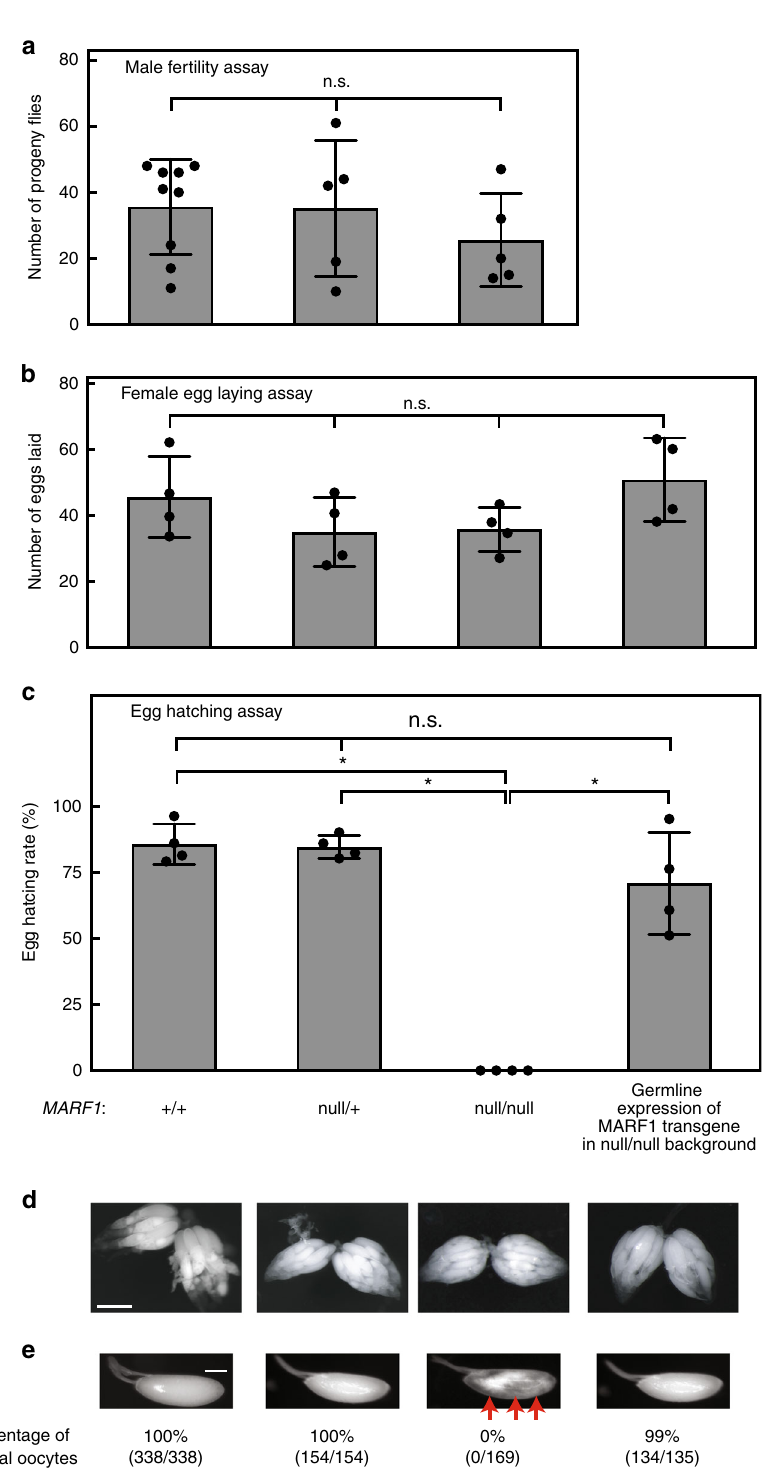
Fig. 2 MARF1 null female fl ies are sterile and have abnormal stage 14 oocytes. a Male fertility assay. Numbers of progeny fl ies from crosses between test males and OregonR wild-type females are shown. Mean ± SD ( n = 10). b , c Female fertility assays. b The numbers of eggs laid by test females crossed with OregonR wild-type males and c the hatching rates of the eggs. Mean ± SD ( n = 3). P -value < 0.05 (Student ’ s t -test) are indicated by *. d Stereomicroscope images of dissected whole ovaries. Scale bar is 500 μ m. e Stereomicroscope images of dissected stage 14 oocytes. Abnormal yolk distribution in MARF1 null stage 14 oocyte is indicated by red arrows. The percentages of normal oocytes are shown. The numbers of normal oocytes/the numbers of observed oocytes are shown in parenthesis. Germline expression of the MARF1 transgene (MAT15Tub-Gal4 → UASP-3xHA-MARF1) in the MARF1 null background rescued hatching rate and yolk distribution in stage 14 oocytes. Scale bar is 100 μ